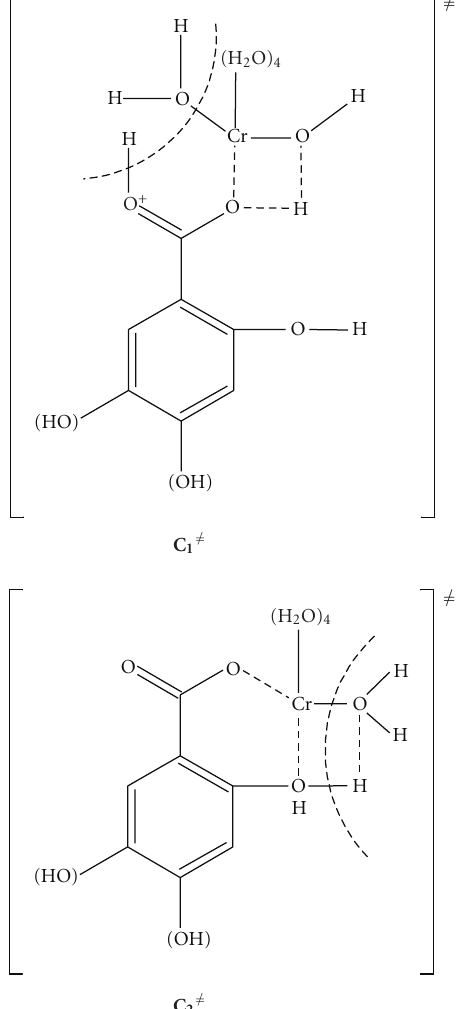
Scheme 2: Activated complexes C / = 1 and C / = 2